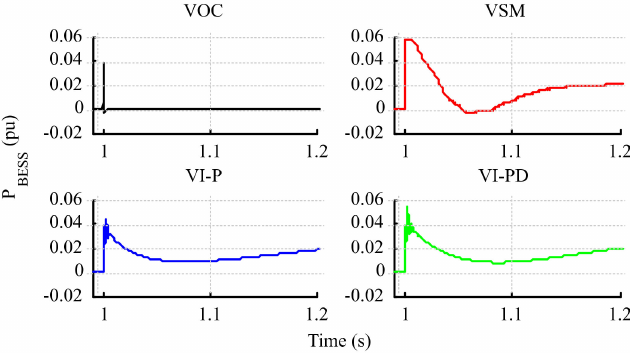
Figure 12. Zoom of BESS active power variation due to a load change. VI-P and VI-PD are the proportional and derivative components of VI,